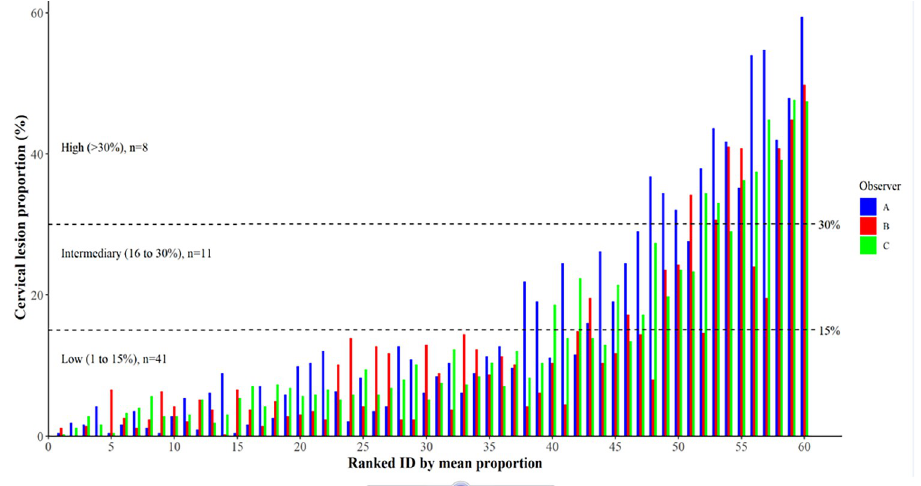
Fig 3. Distribution of cervical lesion proportions (%) for the 60 digital images as rated by the three observers and ranked in accordance with the respective individual mean values.